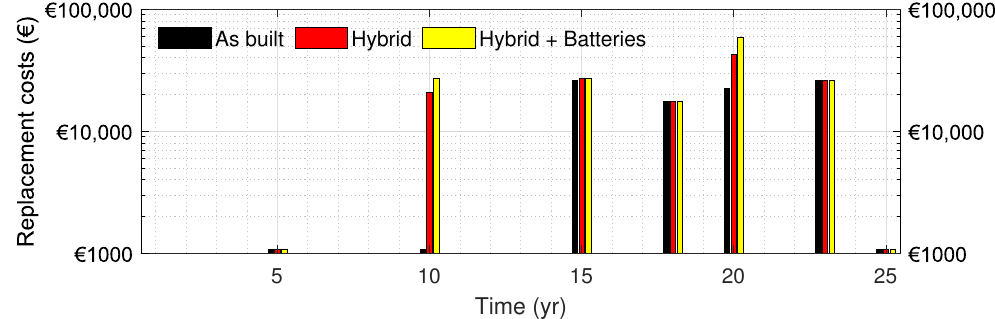
Figure 15. Replacement costs per scenario with integration, Scenarios 2 and 3.